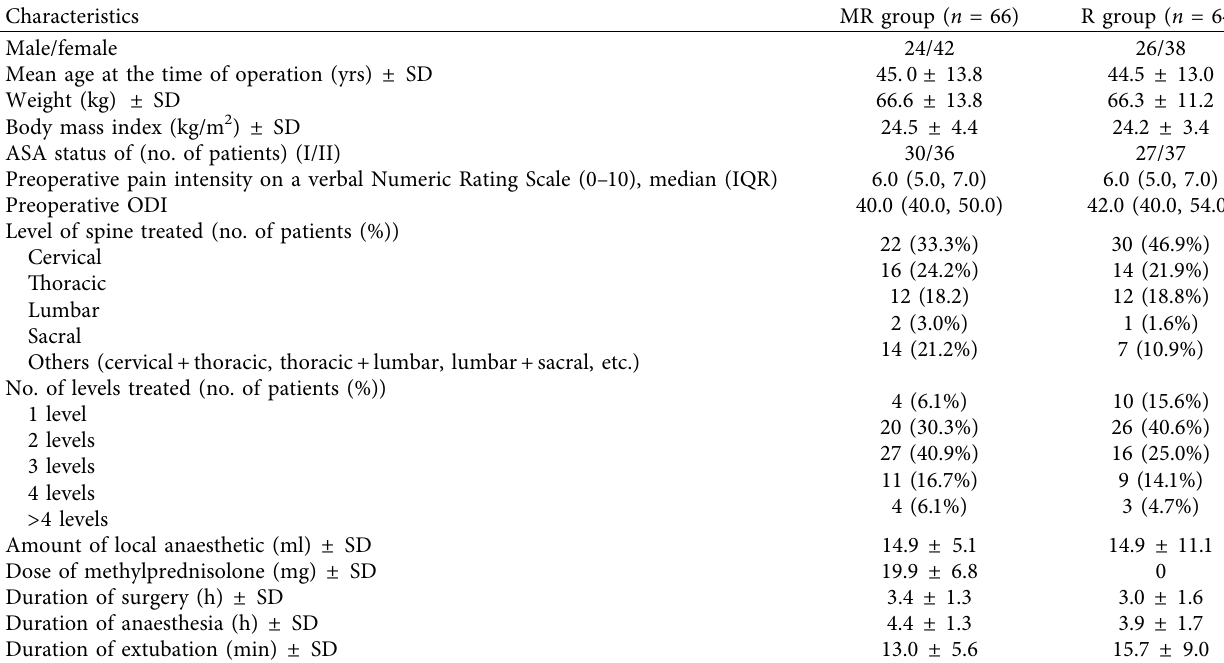
Table 1: Summary of patient